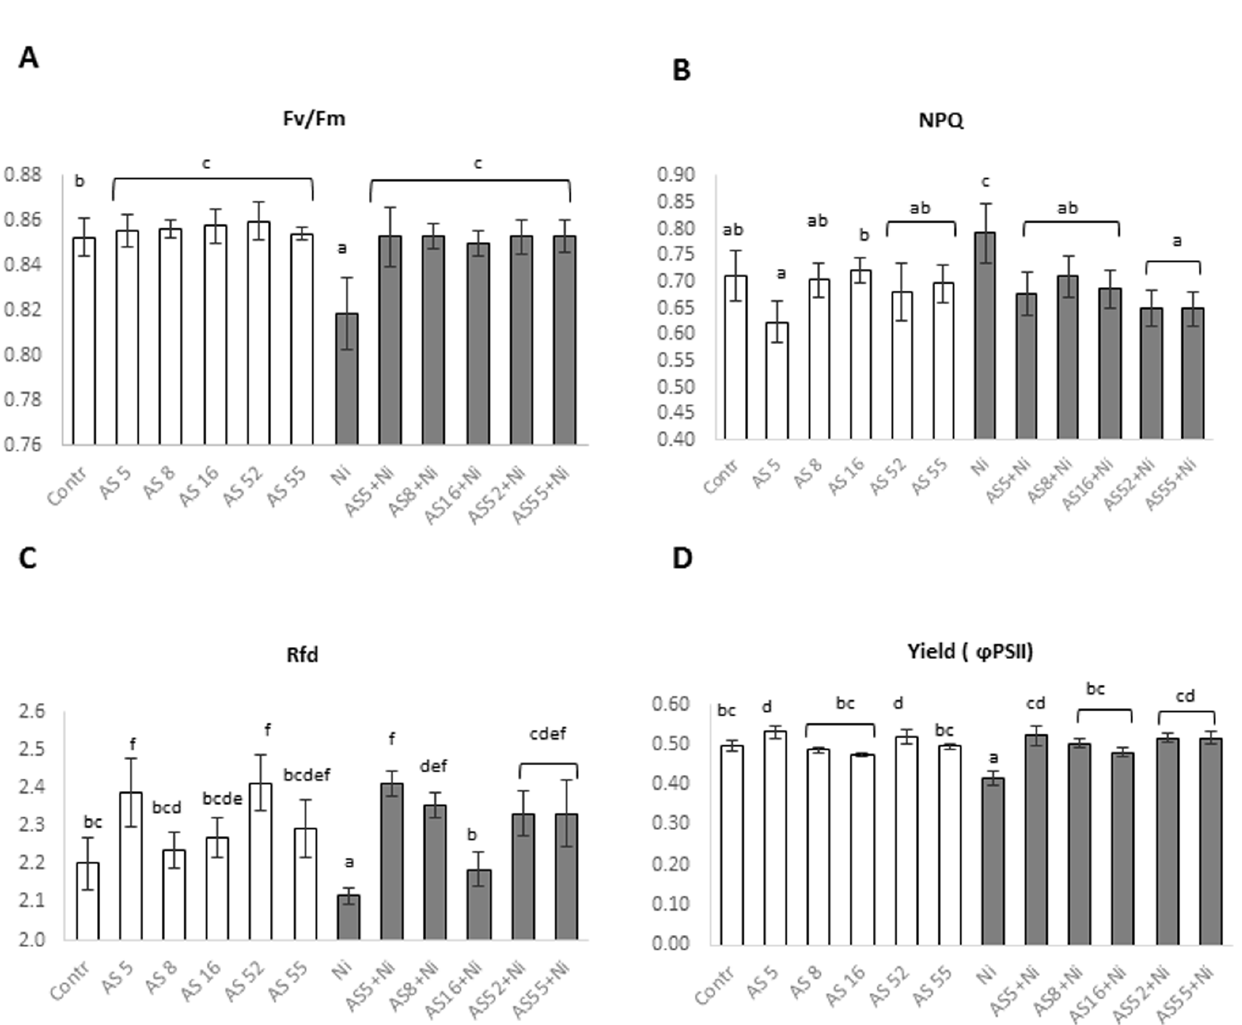
Figure 8. Chlorophyll a fluorescence parameters: ( A ) Fv/Fm—maximum efficiency, ( B ) NPQ—non- photochemical quenching, ( C ) Rfd—vitality index, ( D ) φ PSII—quantum yield of PSII of 4-week-old Arabidopsis plants non-exposed (bars in white) and exposed to 200 µM Ni (bars in grey), in the absence or presence of rhizobia. Error bars represent ± SD. The same letters indicate the homogenous groups according to the Tukey HSD test at the level p = 0.05.